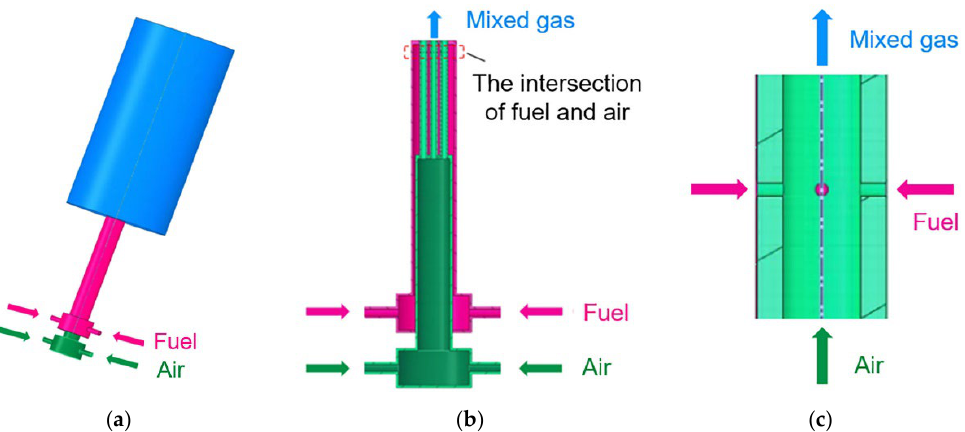
Figure 1. Schematic of the burner structure. (( a ) shows the overall structure of the burner and the combustion chamber, ( b ) shows the center-section view of the burner, and ( c ) shows the details of